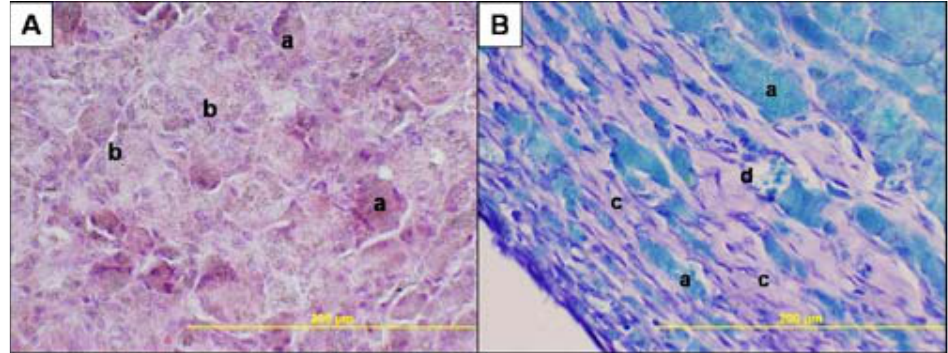
Figure 7. Photomicrograph of a transversal cut of the removed capsule from the injection site after 15 ( A ) and 60 days ( B ). a: groupings of F-SubMGs; b: connective tissue; c: collagen fibers; d: blood vessels. Staining method: Hematoxylin-Eosin ( A ) and Toluidine Blue ( B